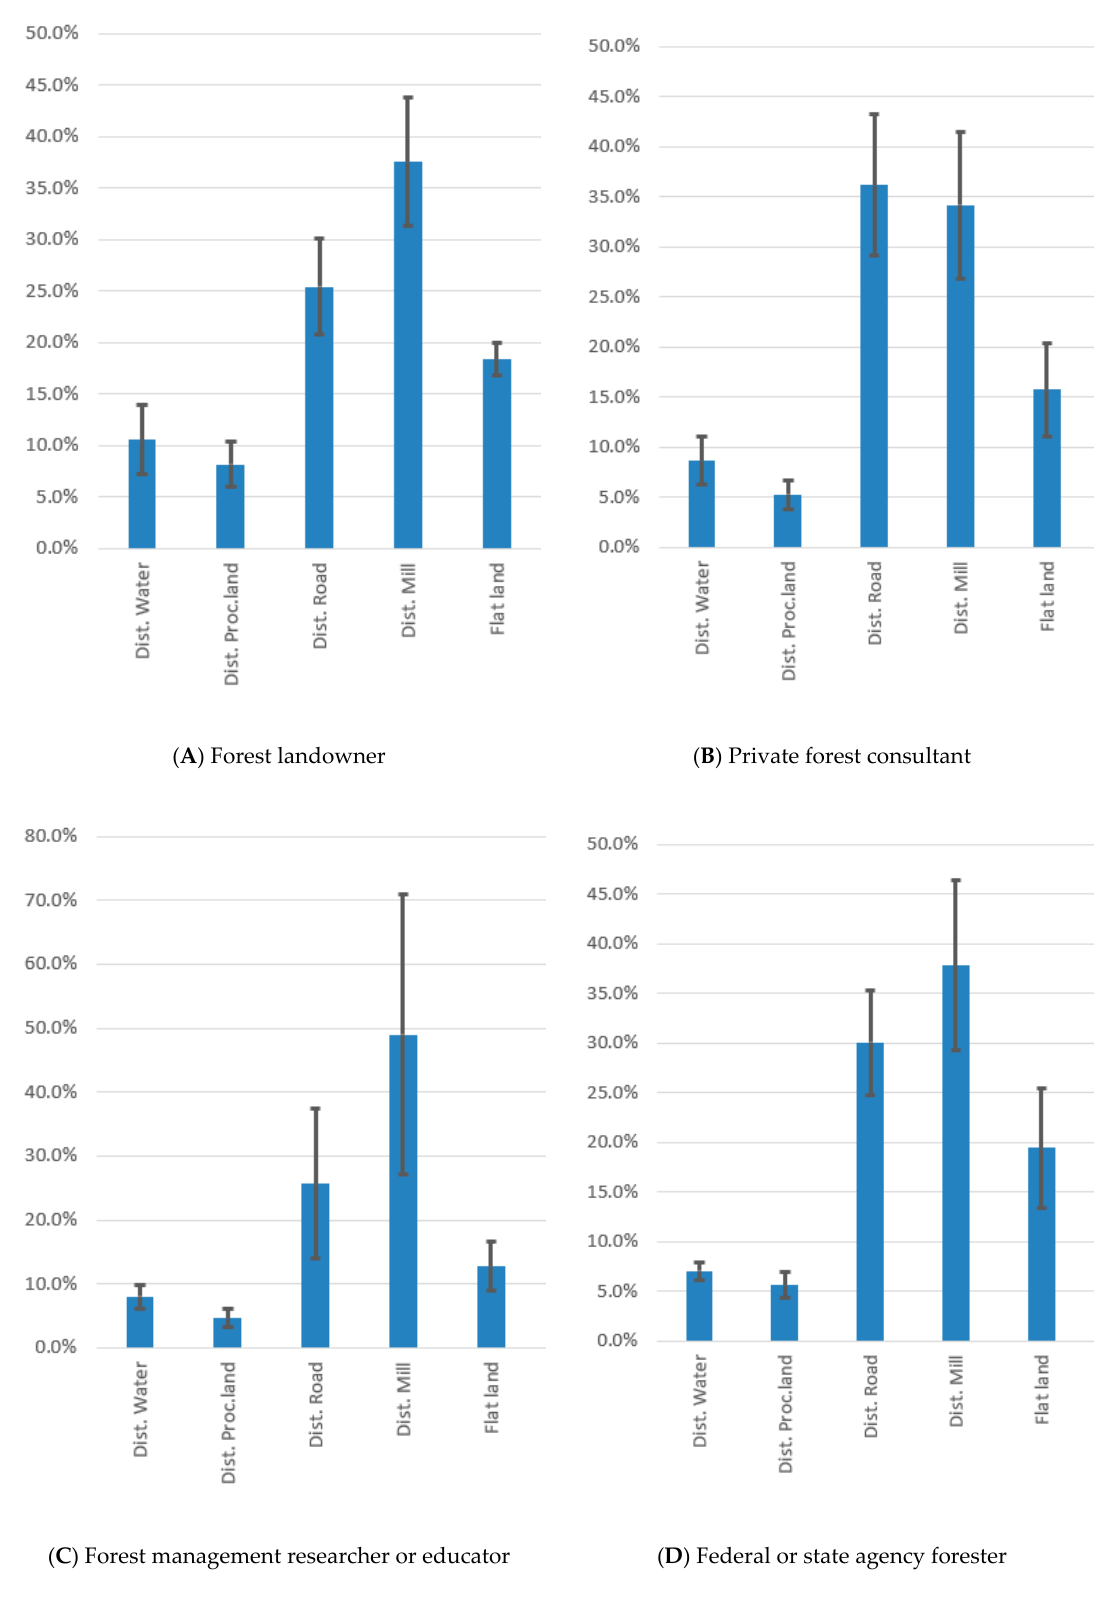
Figure 2. Distribution of stakeholder groups’ weighted criteria.